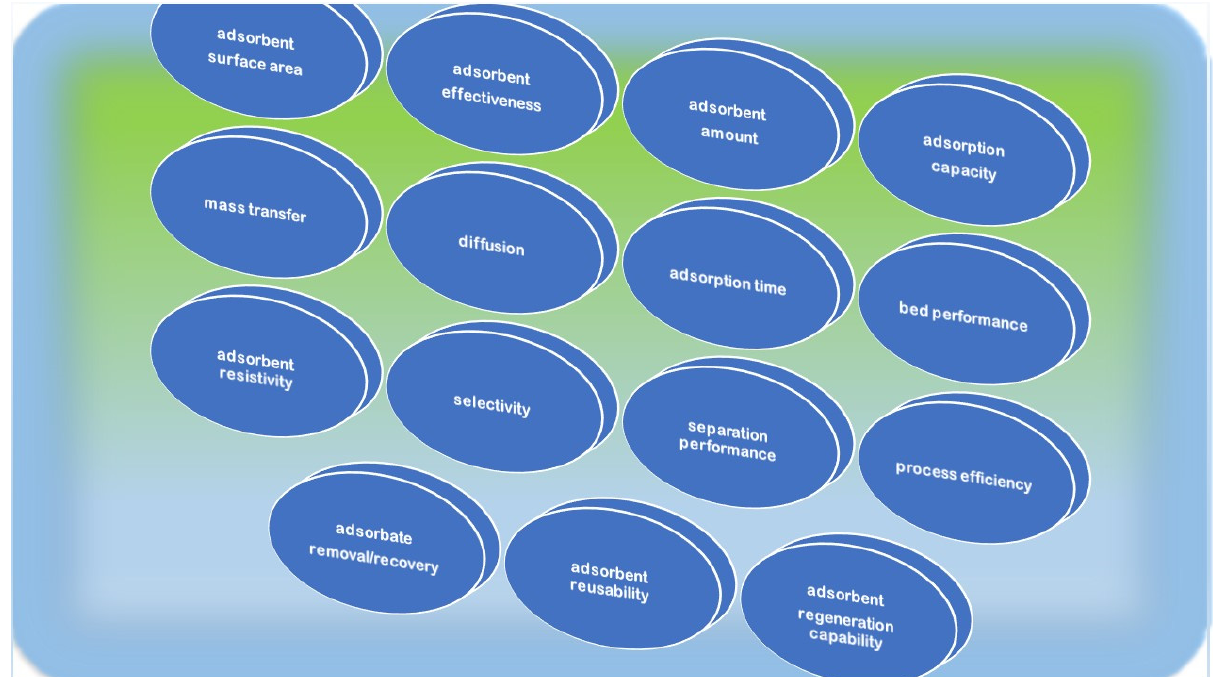
Figure 2. Major intensification parameters considered for water